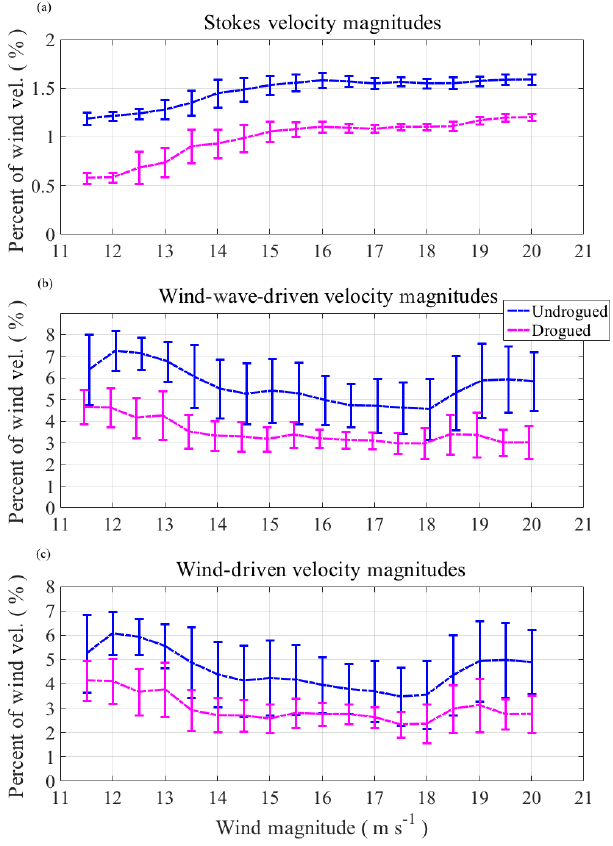
Figure 15. Average velocity magnitudes at drifter locations dur- ing periods of high wind binned by UWIN-CM wind magnitude on 0.5ms − 1 intervals. (a) UWIN-CM Stokes drift velocity magni- tude at the surface (0m) and at 0.4m depth. (b) Velocity magnitude of drogued and undrogued drifters after the subtraction of the pre- existing circulation estimate. (c) Velocity magnitude of the purely wind-driven component of the drifter velocities. All error bars show + / − 1 standard deviation within each bin. Data bins omitted in Fig. 14 are also